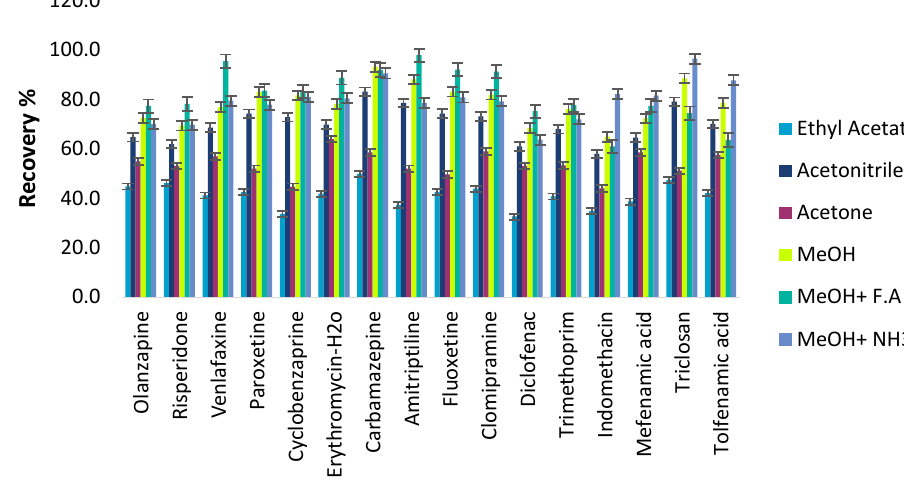
Figure 9. Effect of the desorption solvent on the recoveries of ECs.